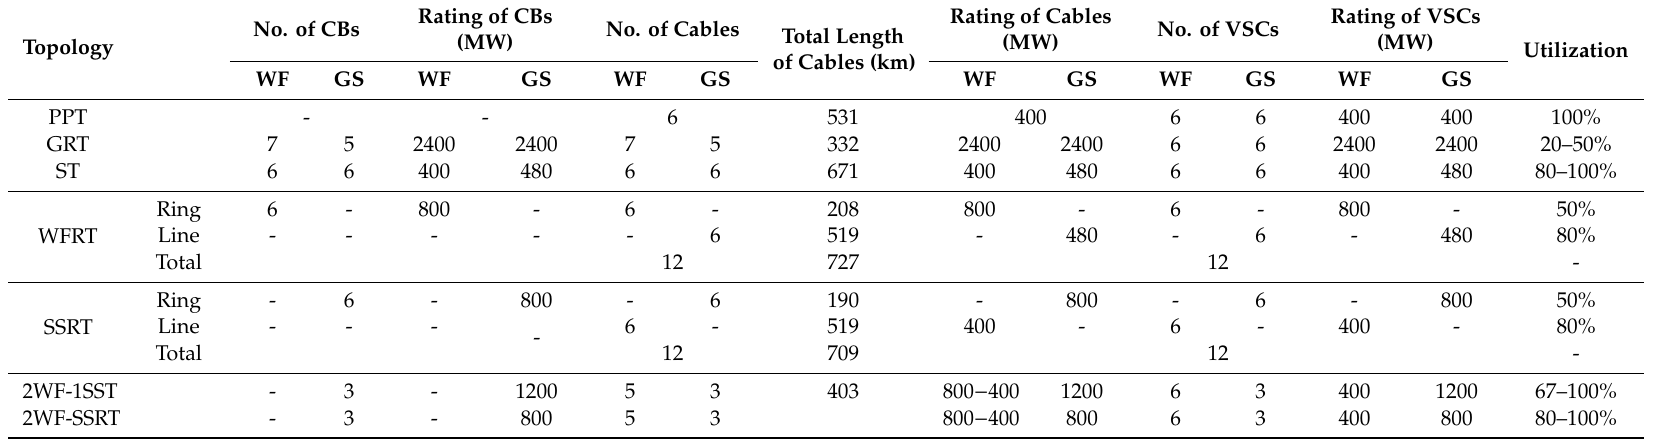
Table 3. Summary of the general case